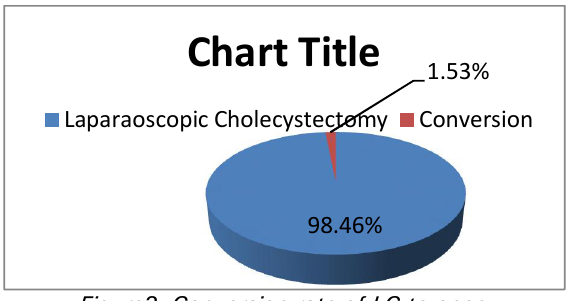
Figure3: Conversion rate of LC to open cholecystectomy